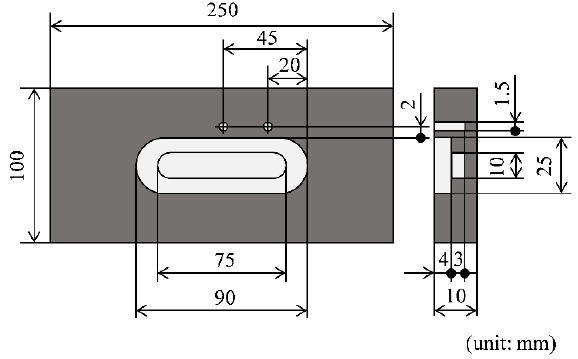
Figure 2. Dimensions of SS400 steel plate.